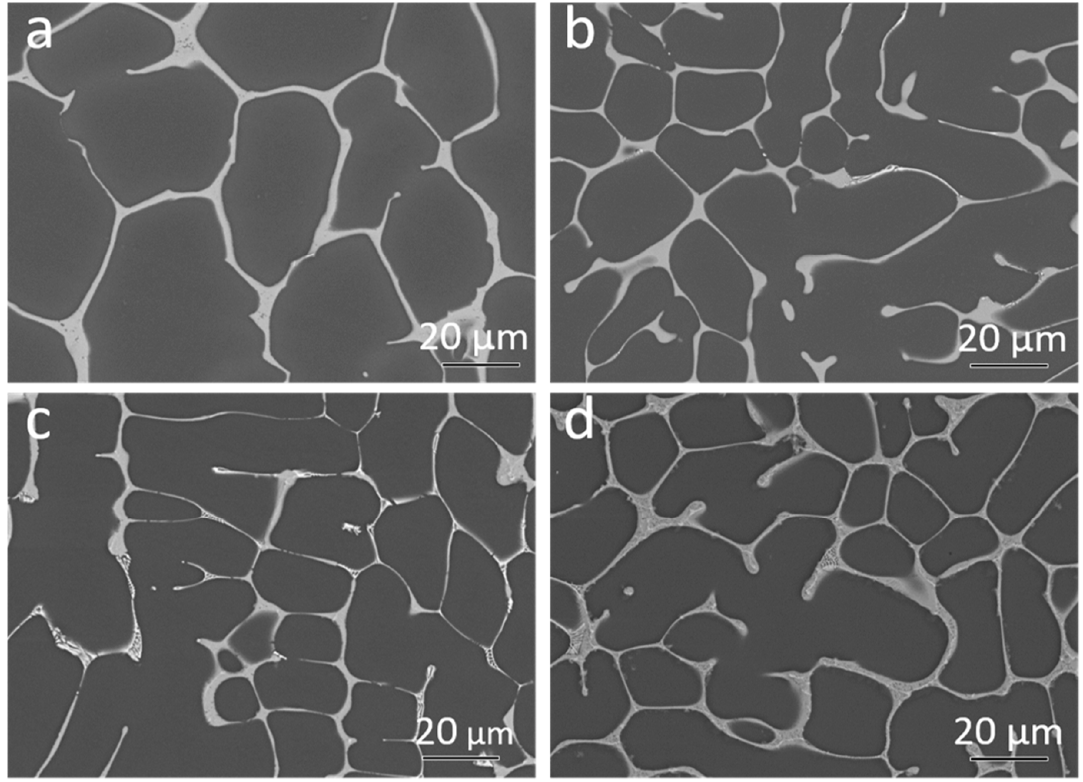
Figure 4. Back Scattered Electron micrographs of the samples after solidification of ( a ) Mg-4Nd; ( b ) Mg-4Nd-3Zn; ( c ) Mg-4Nd-5Zn and ( d ) Mg-4Nd-8Zn.